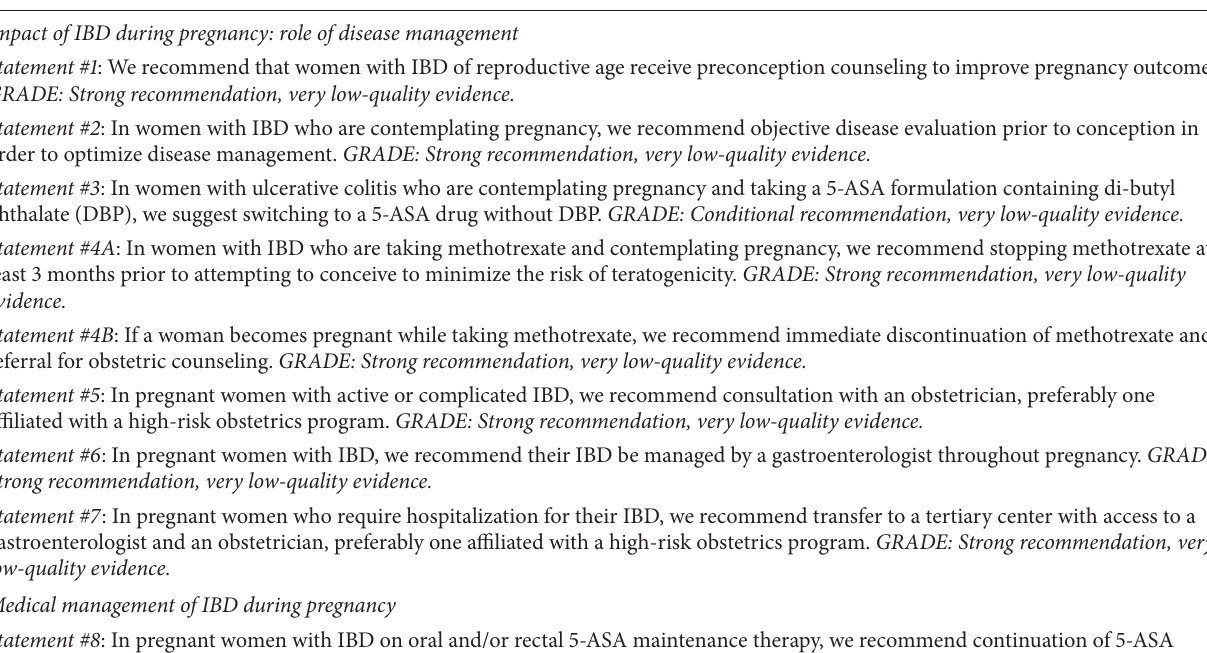
Table 1: Summary of consensus recommendations for the management of IBD in pregnancy. Impact of IBD during pregnancy: role of disease